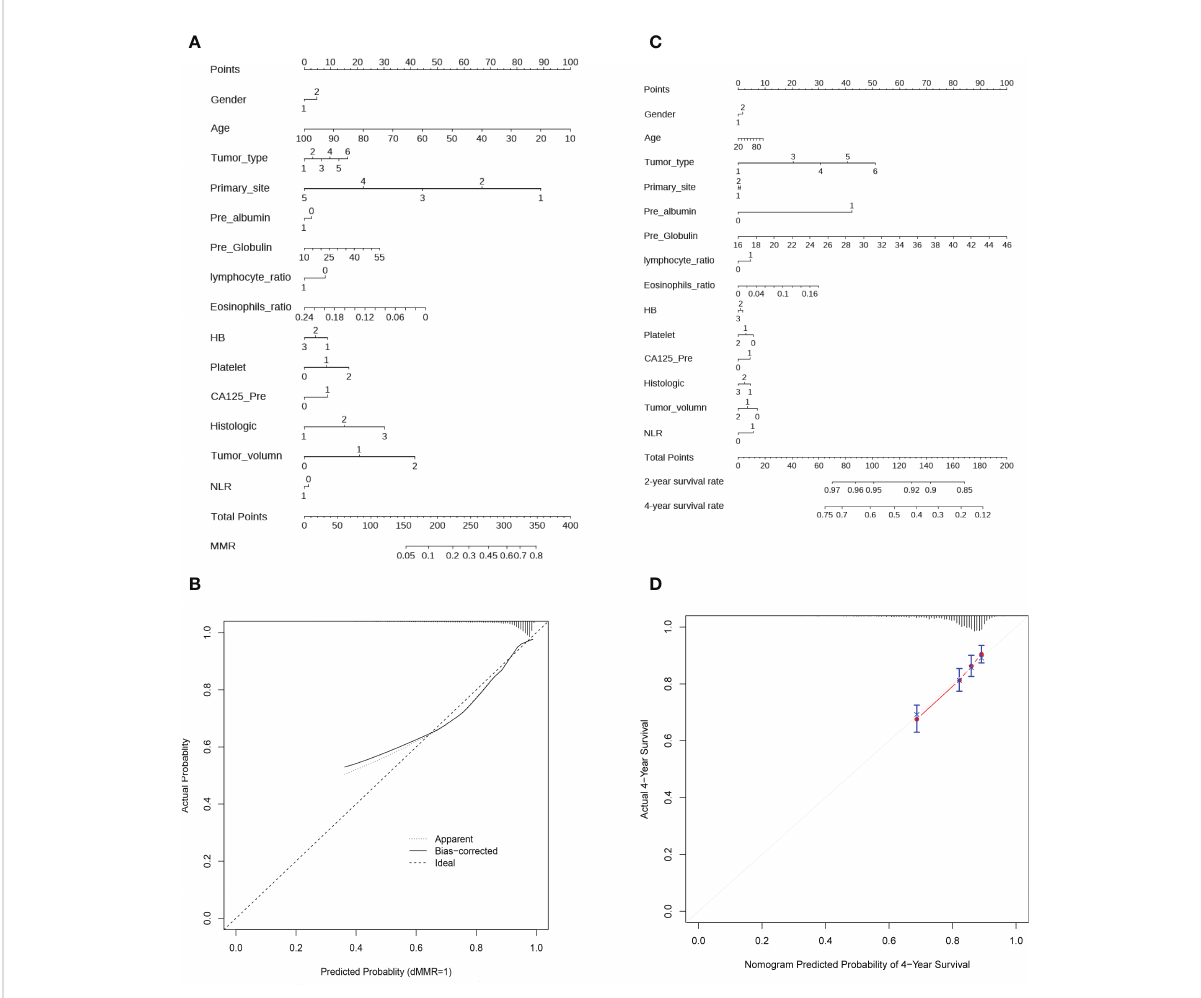
FIGURE 5 Construction of nomogram and calibration diagram. (A) A nomogram to predict the dMMR probability of CRC patients with preoperative routine indexes. In the nomogram, the total points are the sum of individual point for each feature, with larger total points re fl ecting greater probability of dMMR. (B) Calibration curve to evaluate the predictive power of the nomogram. (C) Nomogram to predict the 2- and 4- year OS of CRC patient, with higher total points denoting worse prognosis. (D) Calibration curve for the estimation of 4-year OS predicted by the nomogram. The diagonal dotted line represents theoretical response of perfect nomogram, the red solid line indicates the performance of nomogram. Abbreviations: HB, hemoglobin; NLR, neutral lymphoid ratio; CA125, carbohydrate antigen 125; dMMR, mismatch repair de fi